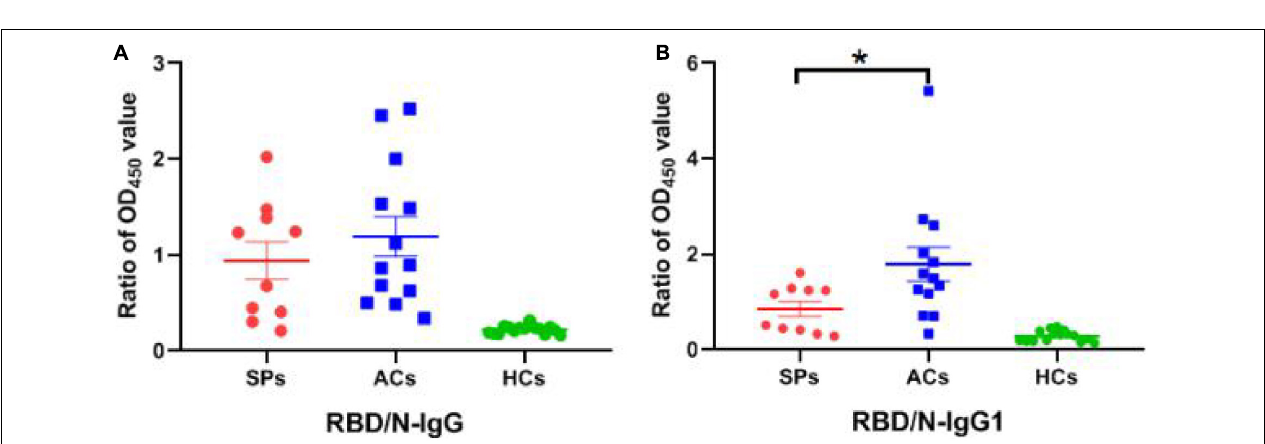
FIGURE 5 | The ratio of OD 450 value of RBD and N-specific IgG between SPs and ACs and HCs. (A) The ratio of RBD-specific IgG OD 450 value between experiment group and HCs. (B) The ratio of N-specific IgG OD 450 value between experiment group and HCs. Data are presented as means ± SEM.